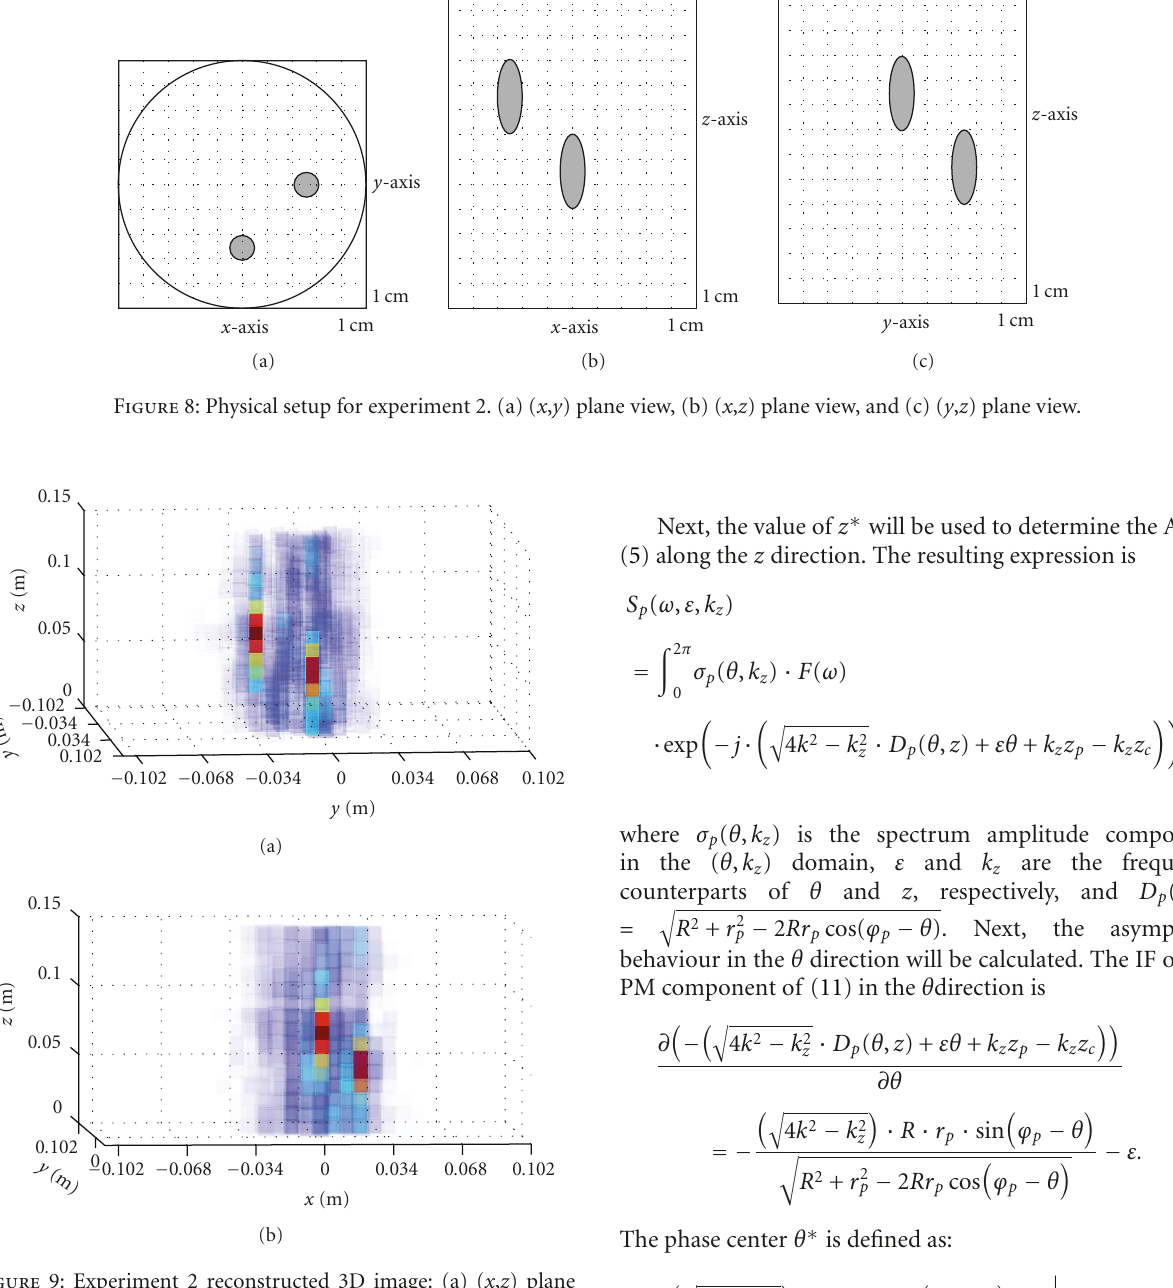
Figure 9: Experiment 2 reconstructed 3D image: (a) ( x , z ) plane view, and (b) ( y , z ) plane